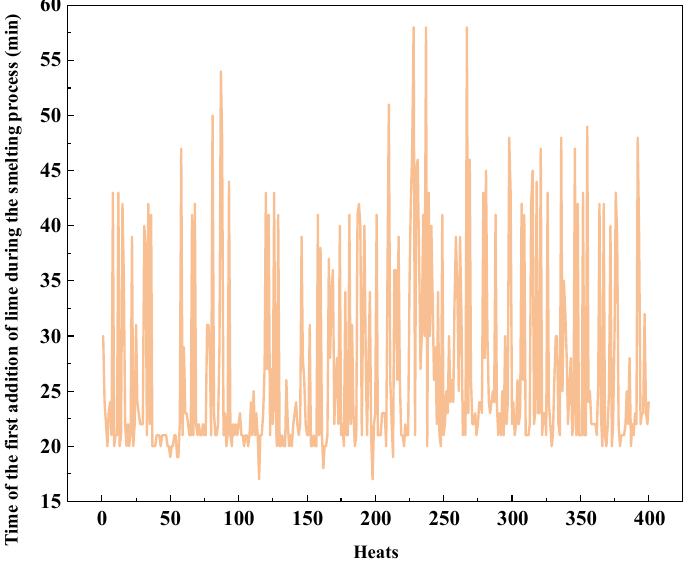
Figure 9. Variation of time of the first addition of lime with heat. Table 5. Characteristic statistics of time of the first addition of lime.